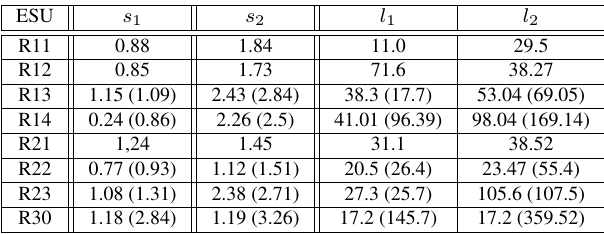
Table 4: Results of two scale roughness representation. In brack- ets the results for the non detrended original surfaces. Units in cm, s 1 , l 1 correspond to the small scale roughness pattern, s 2 , l 2 to the large scale roughness